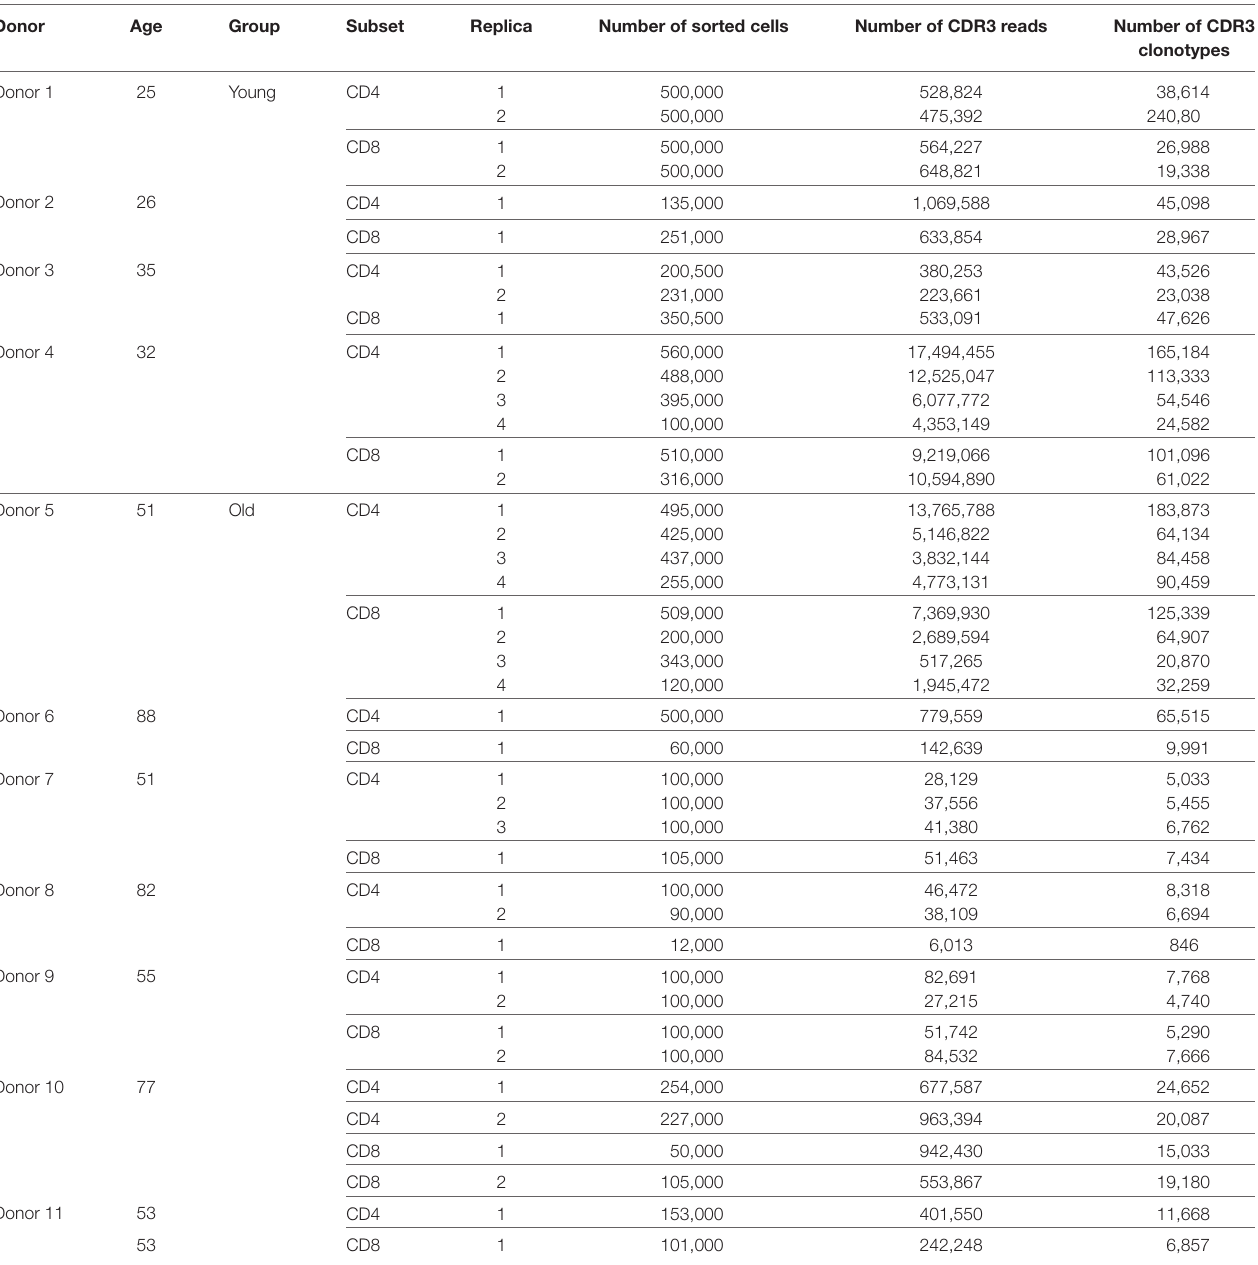
Table 2 | CD4 and CD8 naïve and memory cell